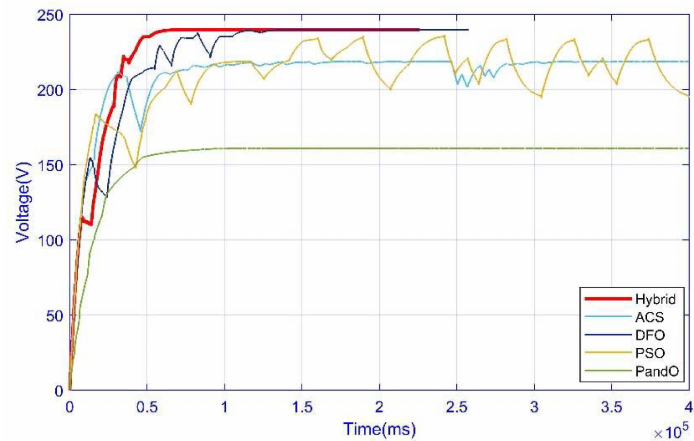
Figure 18. Case 4: Voltage comparison of hybrid with other techniques.